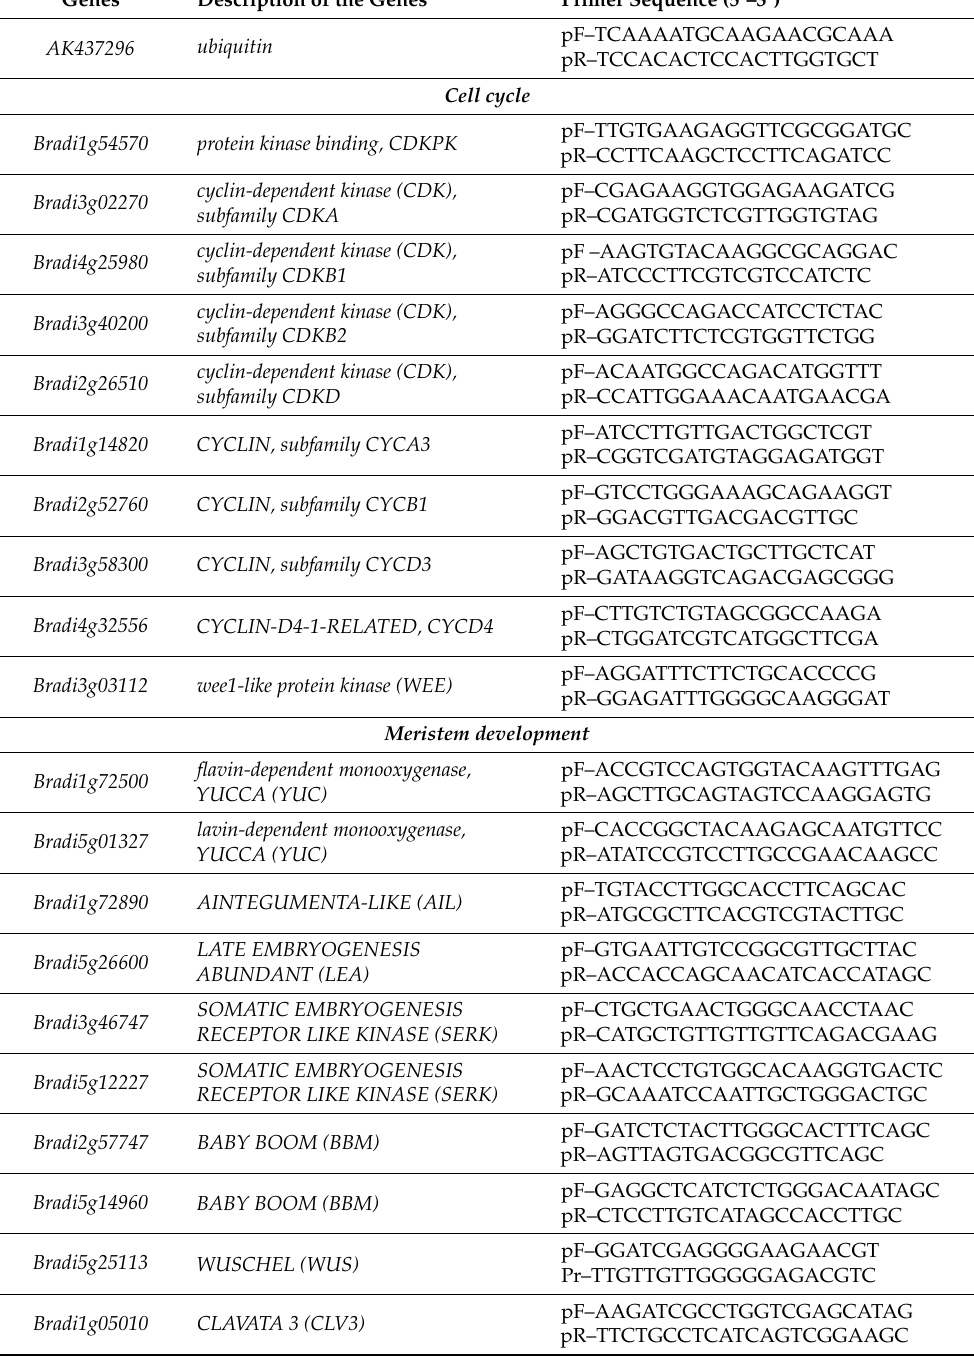
Table A1. Oligonucleotide primers used for RT-PCR reaction with the relevant description of the genes. Genes Description of the